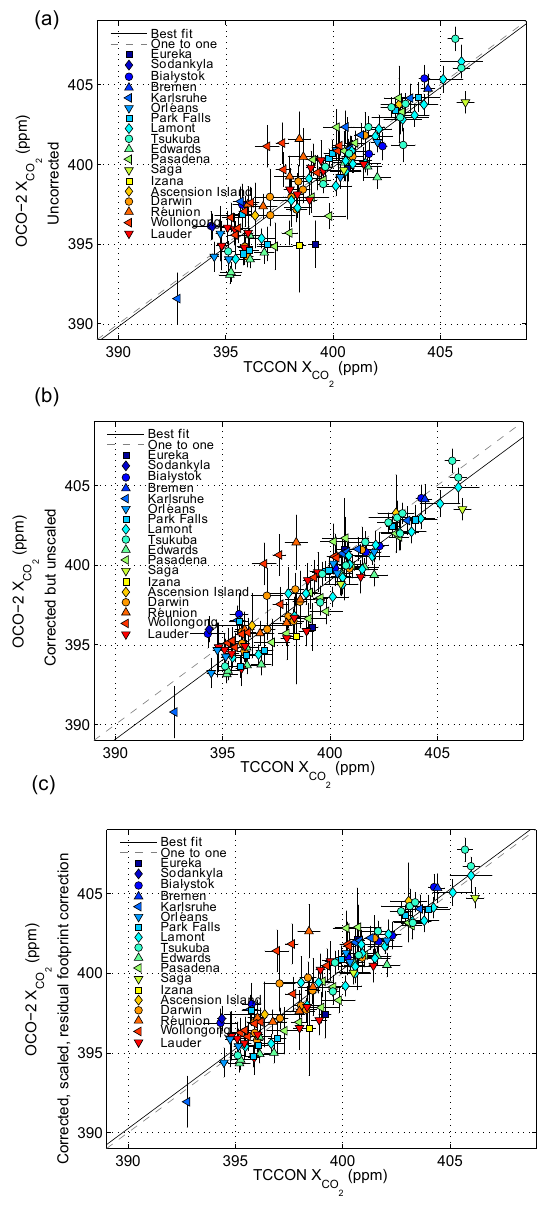
Figure 4. The relationship between the median value from each OCO-2 target-mode maneuver and the median value of the coin- cident TCCON data, typically recorded within 1h of the maneuver. The top plot (a) does not have the Mandrake et al. (2015) bias cor- rection applied and the middle plot (b) is after bias correction but before the scaling is applied. Plot (c) shows the relationship when the scaling correction is applied and the recommended residual foot- print correction described in Mandrake et al. (2015). Note that the best fit line in plot (c) is much more consistent with the one-to-one line than in plot (b) . The slope and scatter in plot (c) is unaffected by the residual footprint correction. The one-to-one line is indicated by the dashed line, and the best fit is marked in the solid line. The error bars represent the standard deviation about the